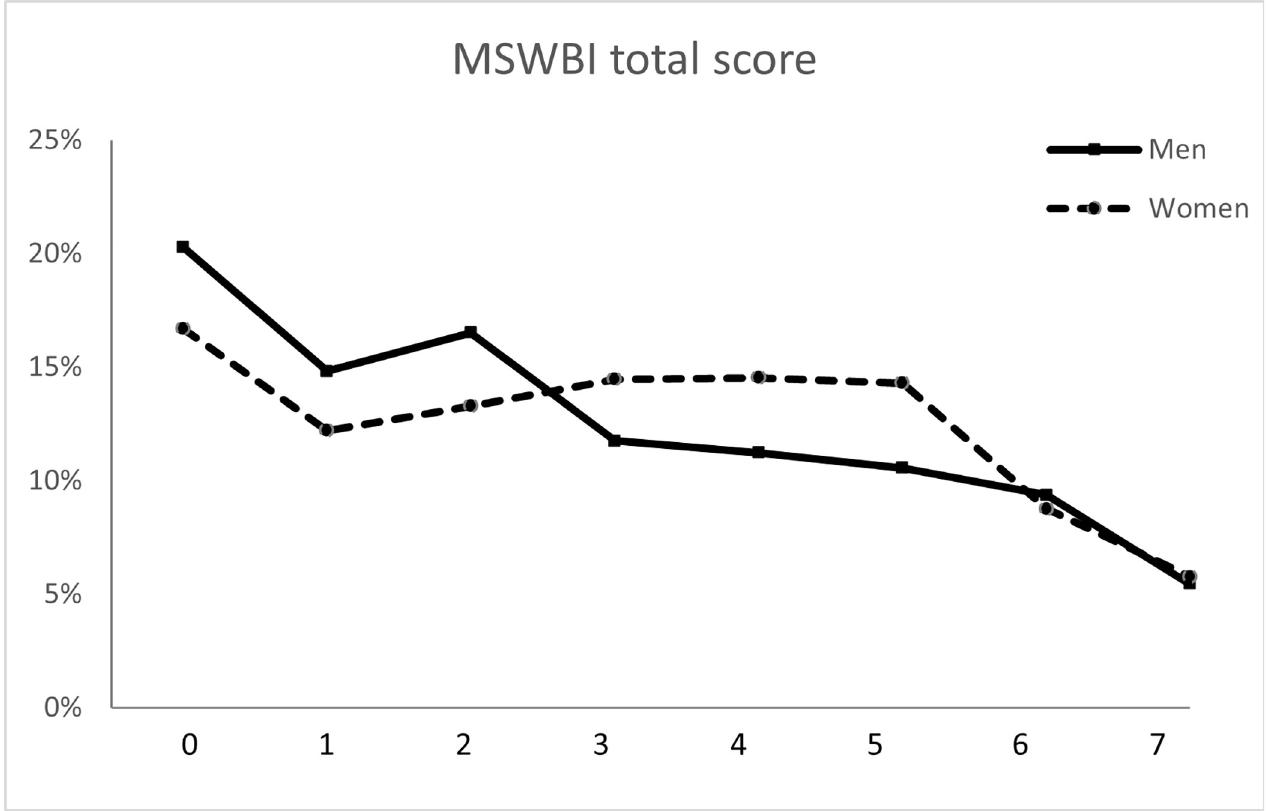
Fig 2. Medical Student Well-Being Index (MSWBI) frequency distribution by gender in 2,264 medical students.